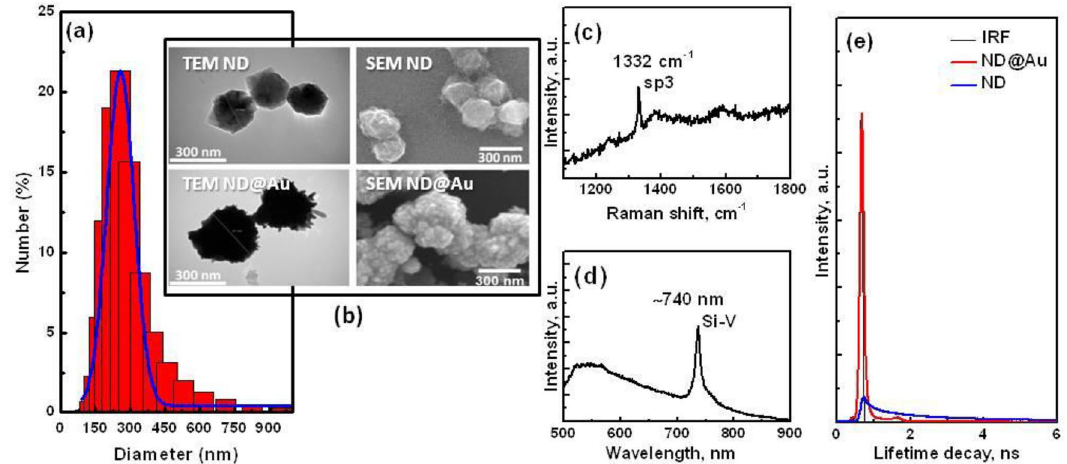
Figure 1. The Au@ND characterization: ( a ) The size distribution of ND@Au measured using DLS method, the average size is 282.8 ± 34.5 nm; ( b ) SEM and TEM images of ND and ND@Au. ( c ) Raman spectrum of ND@ Au in characteristic ranges for ND Raman signals and ( d ) photoluminescence spectrum of ND@Au in the range containing ZPL of SiV PL; 488 nm wavelength laser excitation, laser power at the sample ~ 3 mW; ( e ) Fluorescence lifetime decays of ND and ND@Au at two-photon excitation, and calculated instrument response function (IRF), excitation 800 nm, laser power 1.5 mW for ND@Au, 14 mW for ND at the input to PicoHarb scanning